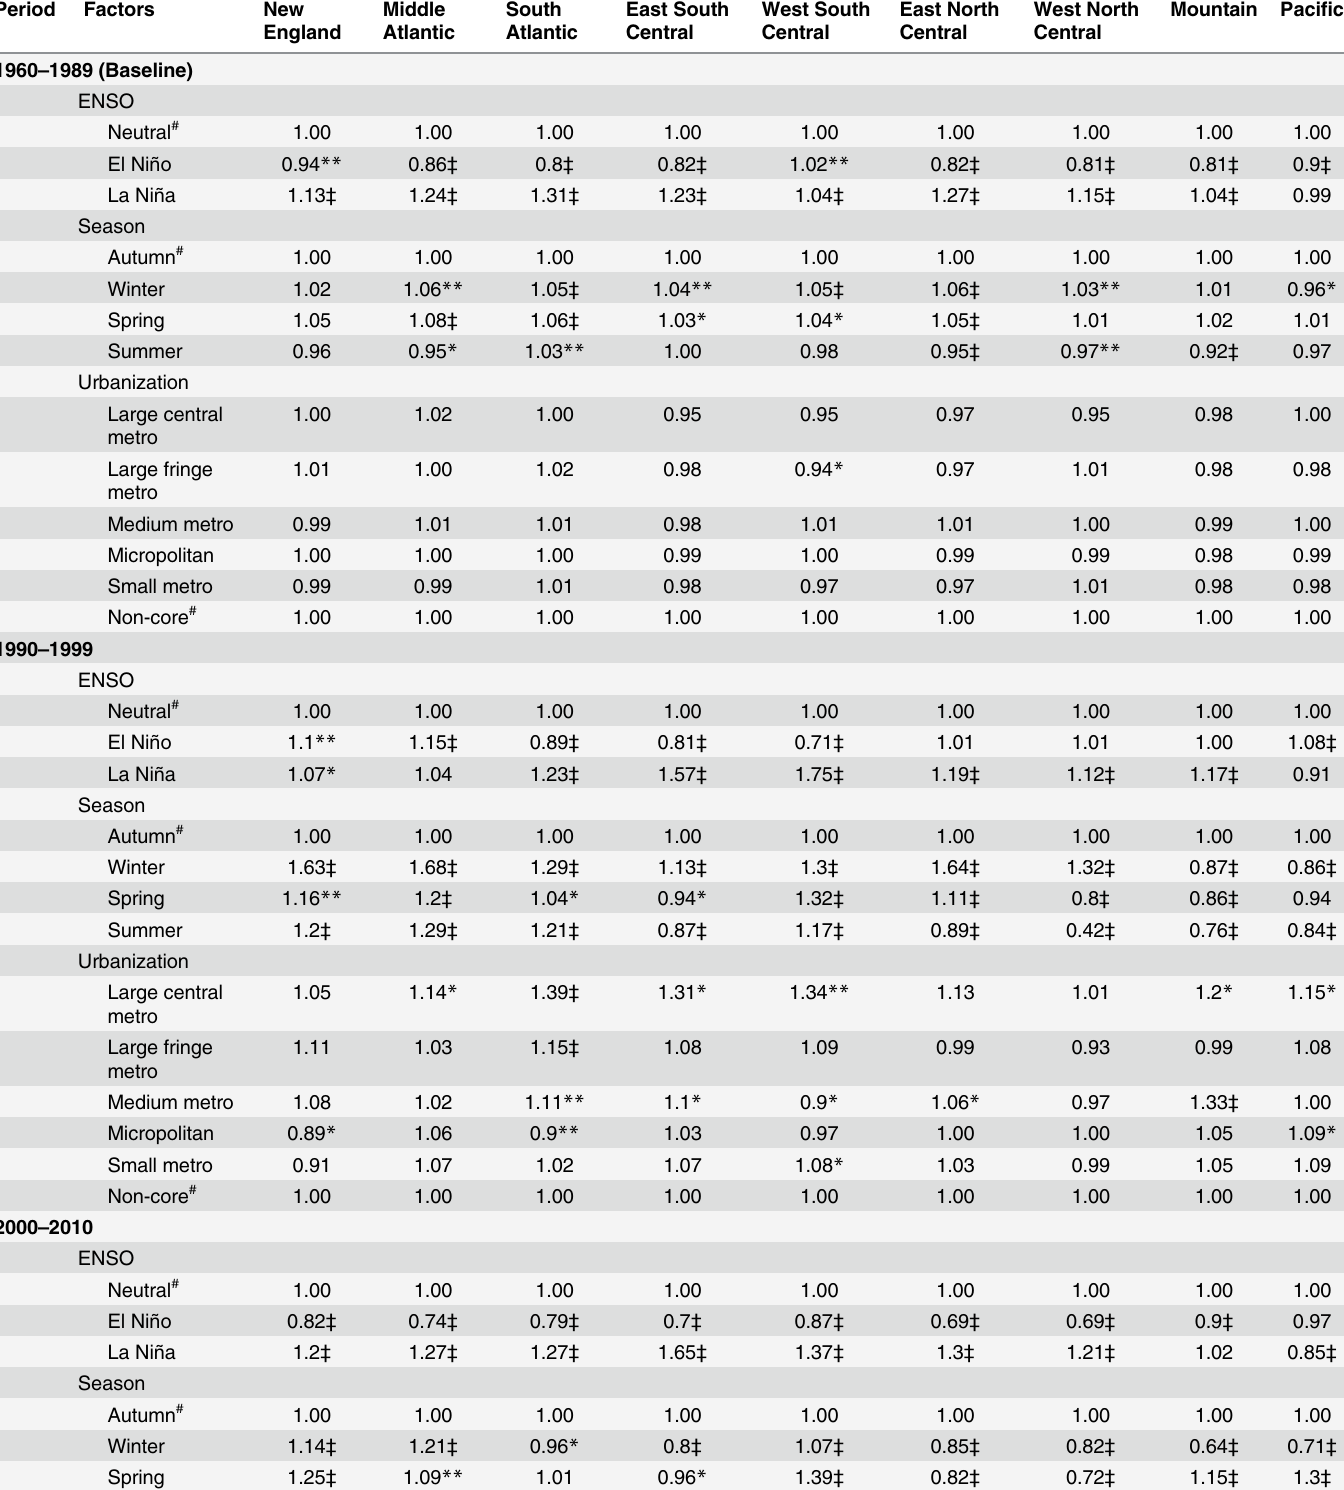
Table 4. Relative percent change in count of extreme heat events, by Census Division (excluding Alaska and